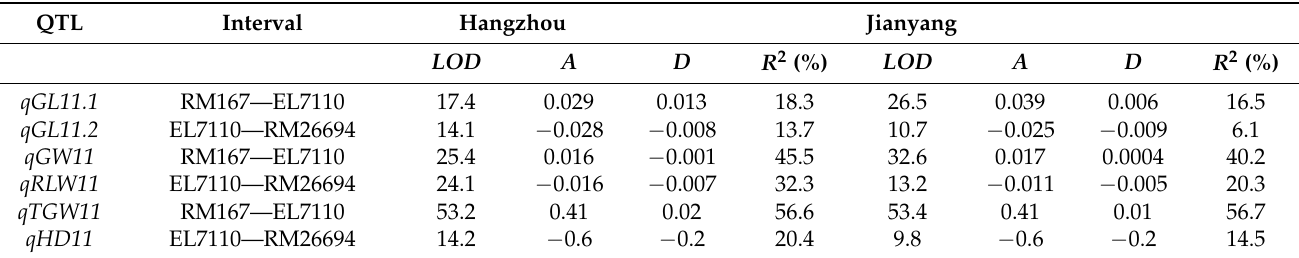
Table 3. QTLs detected in the ZL1 population.